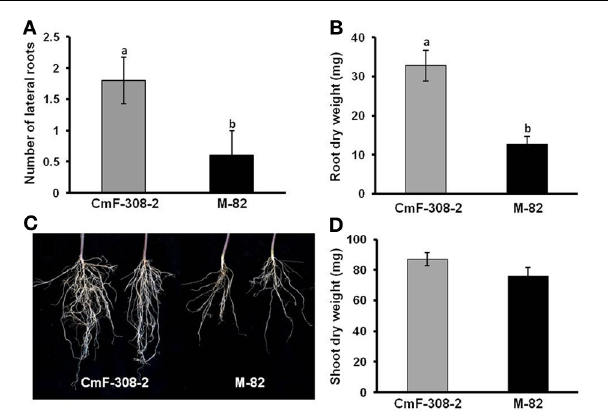
FIGURE 5 | Effect of CmF-308 expression in the phloem of tomato plants on root development. Number of lateral roots (A) , root dry weight (B) , and a picture (C) presenting the differences between roots of transgenic tomato plants expressing CmF-308 under the AtSUC2 promoter (CmF-308-2) as compared with the control variety M-82. (D) Shoot dry weight of transgenic tomato plants expressing CmF-308 under the AtSUC2 promoter (CmF-308-2) as compared with the control variety M-82. Lateral roots were counted in 9-days old seedlings germination on germination papers (A) . Shoot and root weight was measured in 3-week old pot-grown plants (B–D) . Data represent means of six replications ± SE. Different letters indicate significant differences between the plant lines at p < 0 . 05 by Student’s t -test.